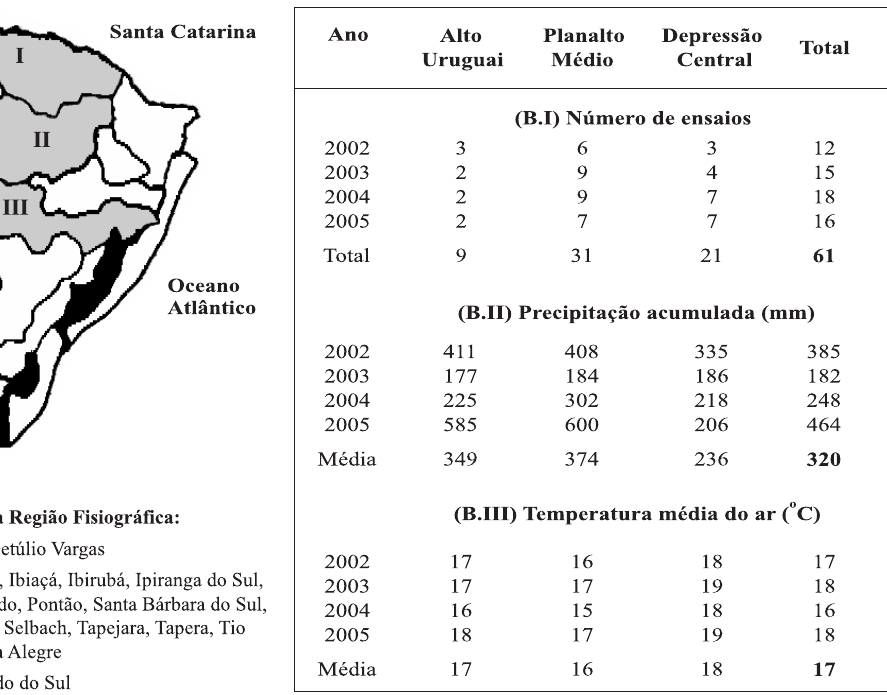
Figura 1. Localização das Regiões Fisiográficas e municípios onde os ensaios foram instalados no Rio Grande do Sul (A). Distribuição dos ensaios nas três Regiões Fisiográficas nos quatro anos (B.I) e elementos meteorológicos (precipitação pluvial acumulada (B.II) e temperatura média do ar (B.III)) nos meses de maio e junho, nas estações meteorológicas de cada Região